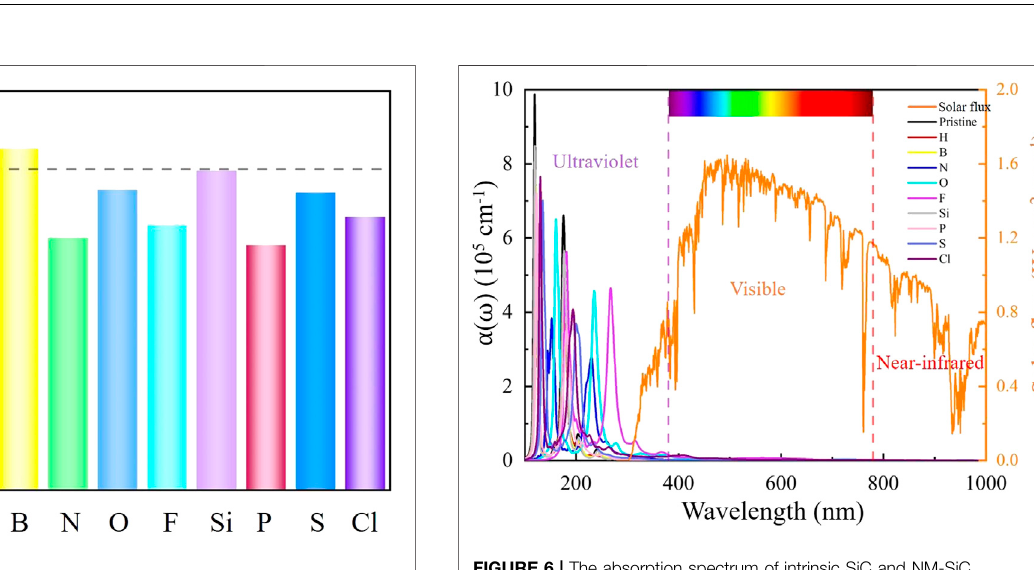
near the doping atoms and the neighboring atoms. The corresponding magnetism is primarily caused by the doping NM atoms, while the adjacent atoms make a smaller contribution. For metals, the magnetic moment is calculated